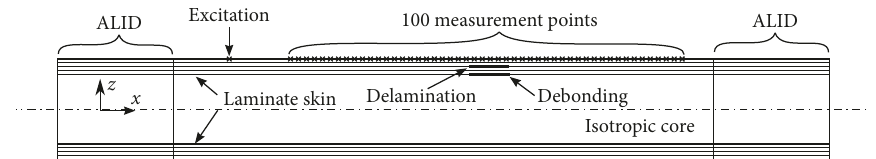
Figure 1: Schematic view of the numerical model including the approximate locations of the